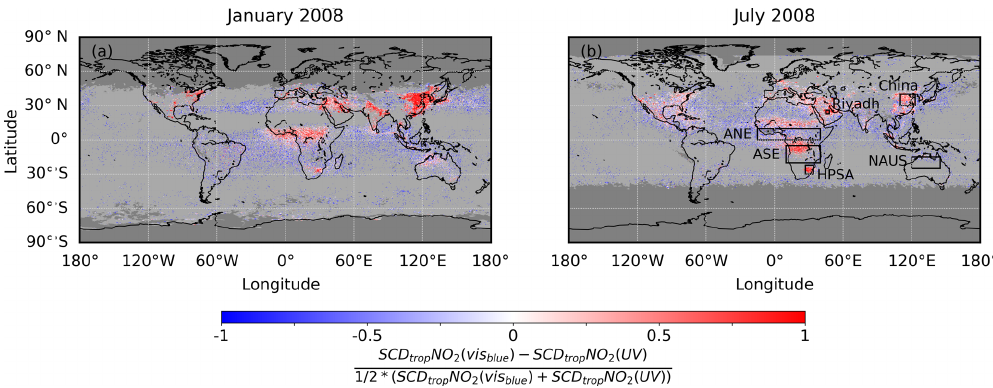
Figure 8. Relative difference between monthly mean tropospheric NO 2 SCDs in the UV and blue spectral range. Differences for (a) January and (b) July 2008. Dark grey shaded area: no NO 2 values available. Light-grey-coloured values indicate values where the vis blue NO 2 is close to zero, which have been filtered out. This threshold was defined as a smoothed latitude-dependent mean over the reference sector area. The Pacific threshold is 1 standard deviation of the gridded NO 2 values for both retrievals. To smooth the latitude-dependent threshold, a 5 ◦ running mean was used. The regions defined in Table 3 are depicted in panel (b) .